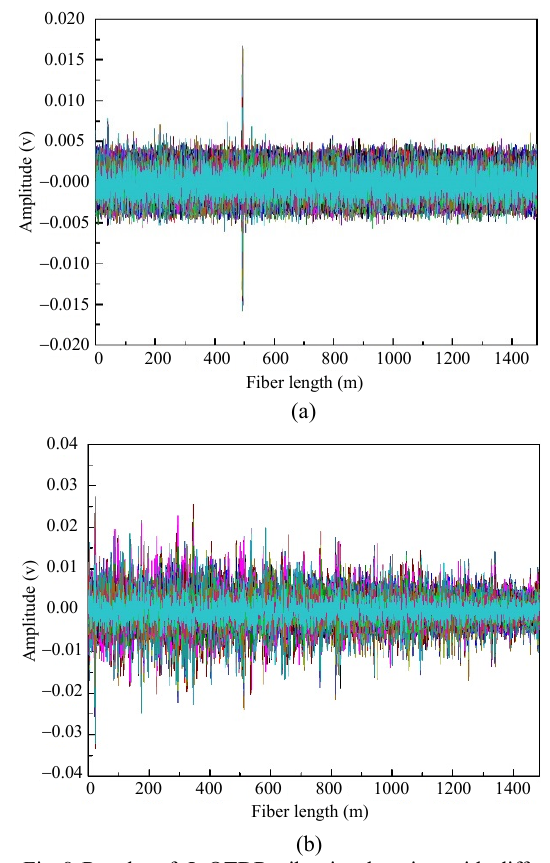
Fig. 8 Results of Φ -OTDR vibration locating with different light source: (a) the location information for the averaging times of 10 by using a narrow linewidth laser and (b) the location information for the averaging times of 10 by using the same medium-coherence as our